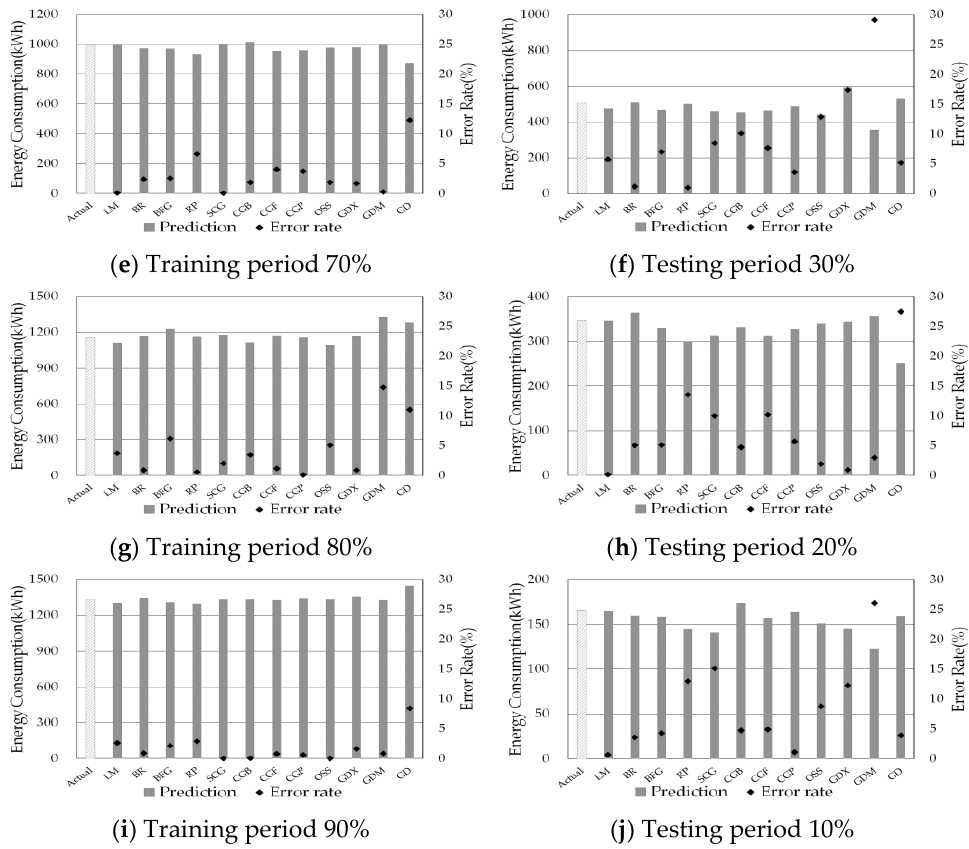
Figure 3. Prediction results with training period 50 – 90%/test period 50 – 10% in data.